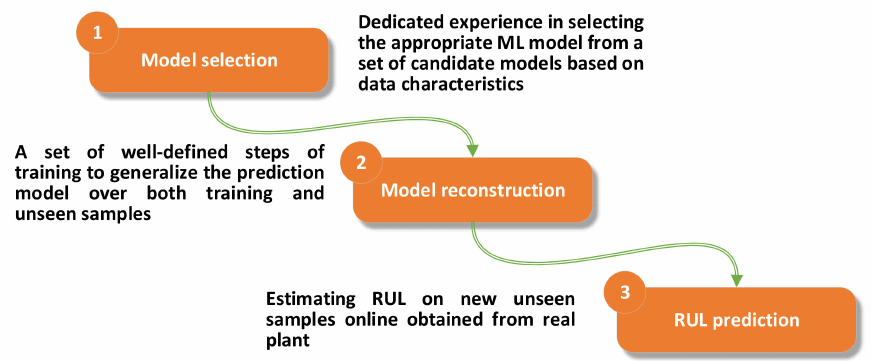
Figure 1. Necessary steps for constructing an RUL prediction model with ML